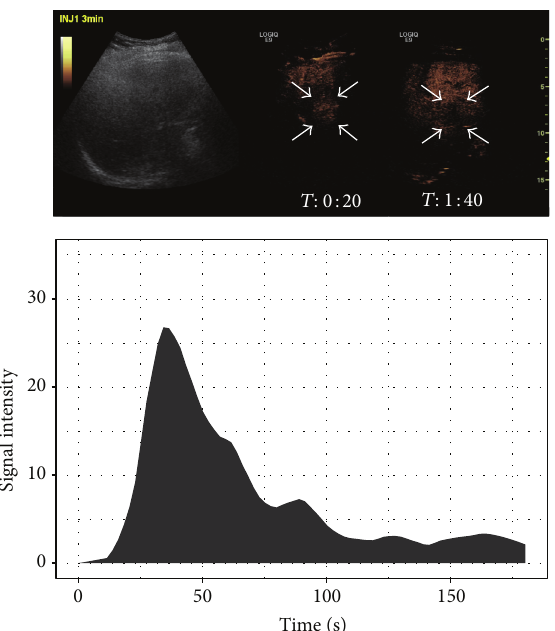
Figure 1: Typical HCC showing a washout starting in the portal- venous phase in B-mode US and CEUS with the corresponding time-intensity curve.